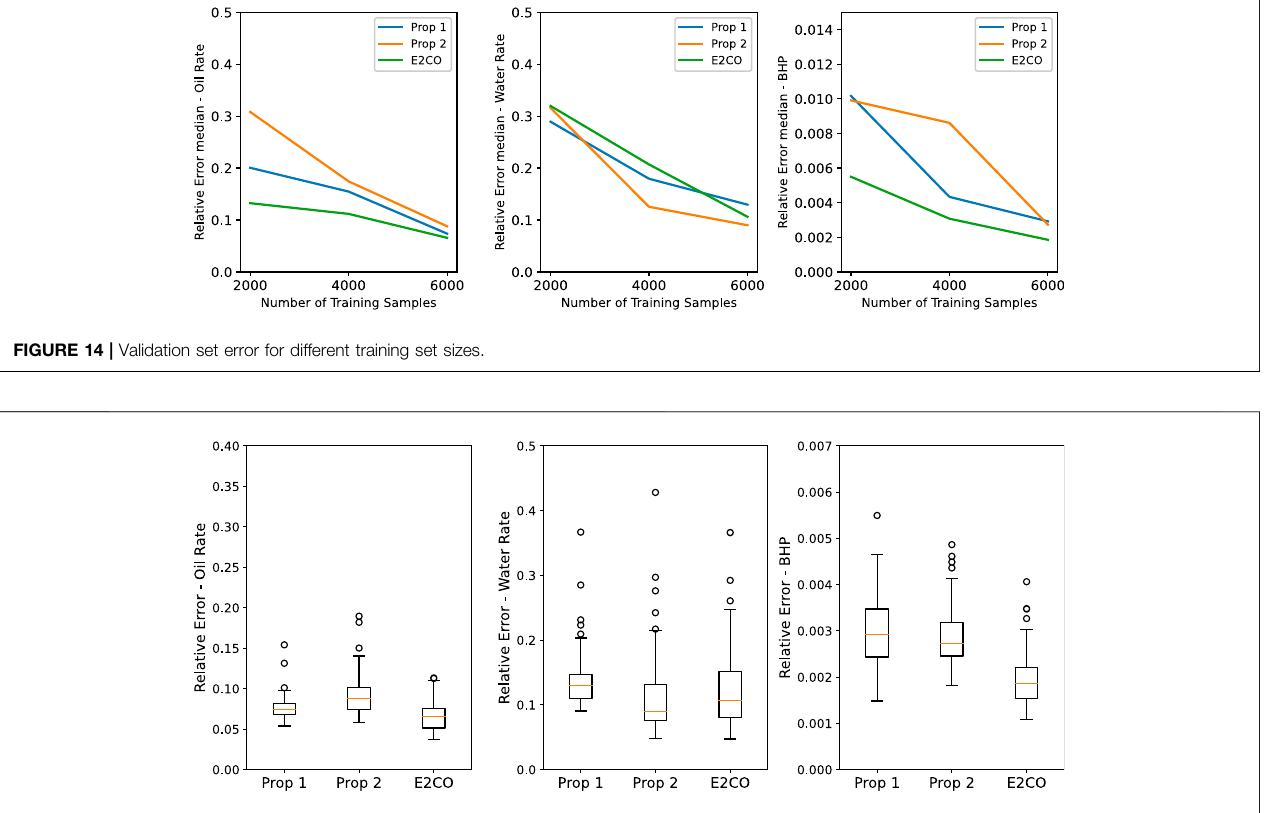
FIGURE 15 | Validation set error on the 3 propositions for oil rate (left plot) , water rate (middle plot) and BHP (right plot) .